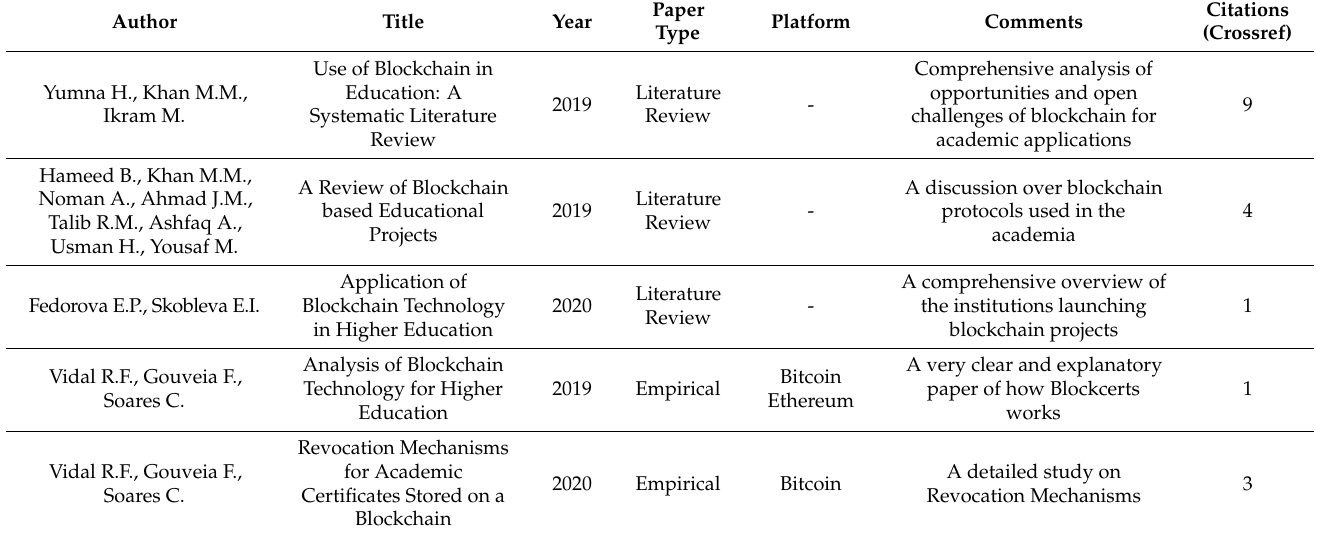
Table A1. Sample of the data extraction with